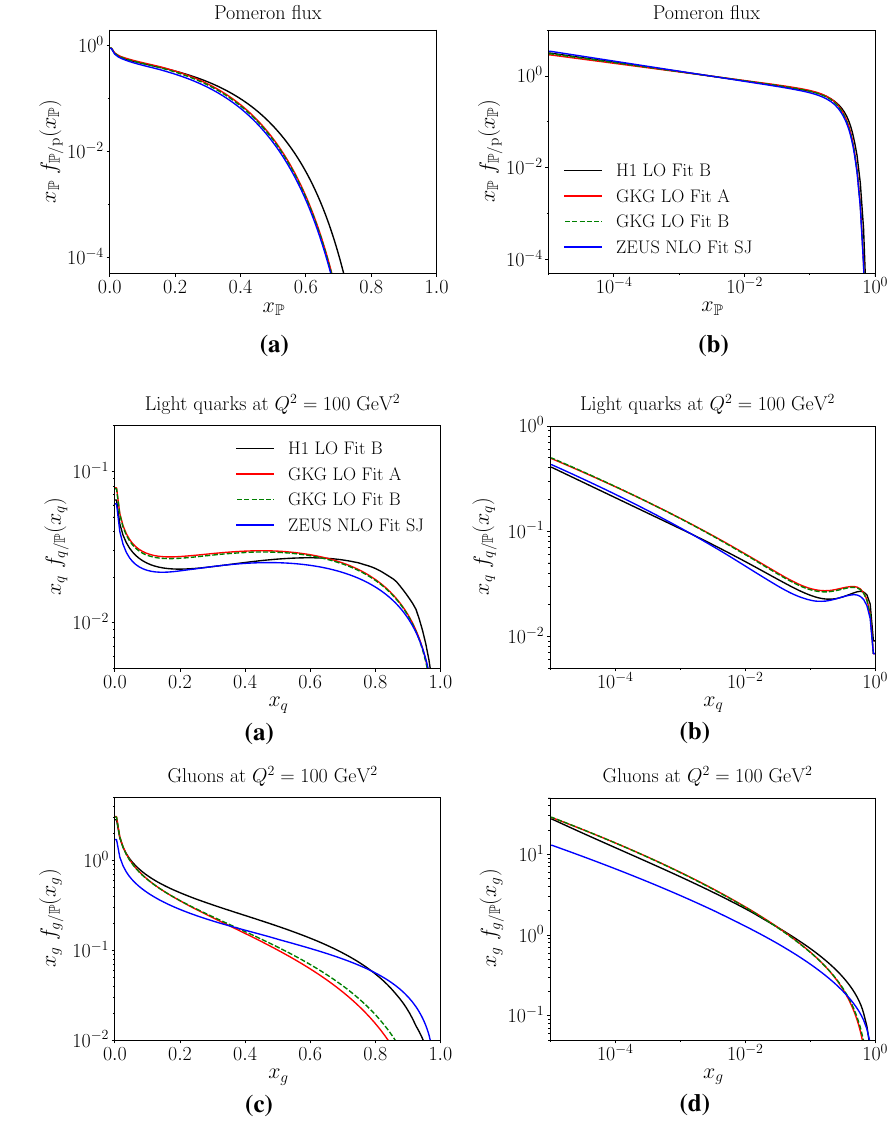
Fig. 4 The GKG18 LO Fit A, B and ZEUS SJ fluxes on a linear ( a ) and logarithmic ( b ) scale in x P . Note that t has been integrated over its kinematical (cid:12) range, f ( x P ) = d t f ( x P , t )